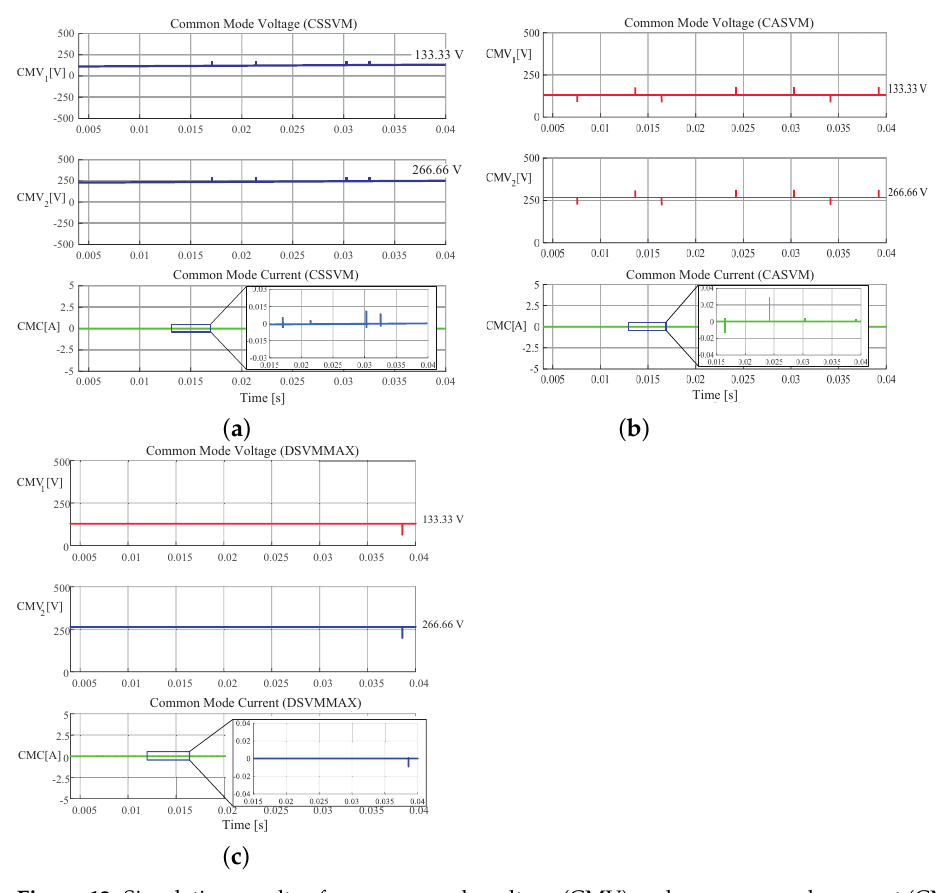
Figure 12. Simulation results of common mode voltage (CMV) and common mode current (CMC) of the three-phase DCM-232 inverter under the ( a ) CSSVM, ( b ) CASVM, and ( c ) DSVMMAX techniques.